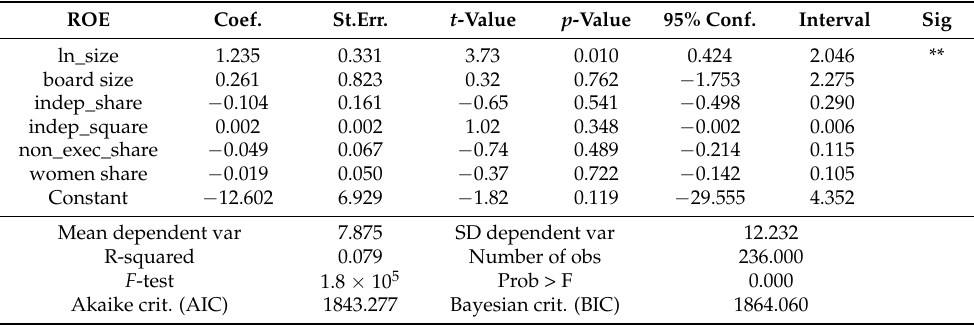
Table A1. Non-Linear Model with Board Characteristics.